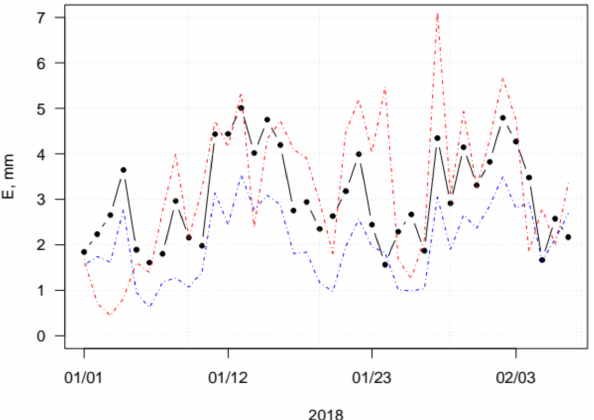
Figure 7. The daily time series of evaporation (mmd − 1 ) calculated by the EC method (black), by the bulk-aerodynamic method (blue), and by the new combination equation (red) applying the meteoro- logical measurements at the Maitri site.